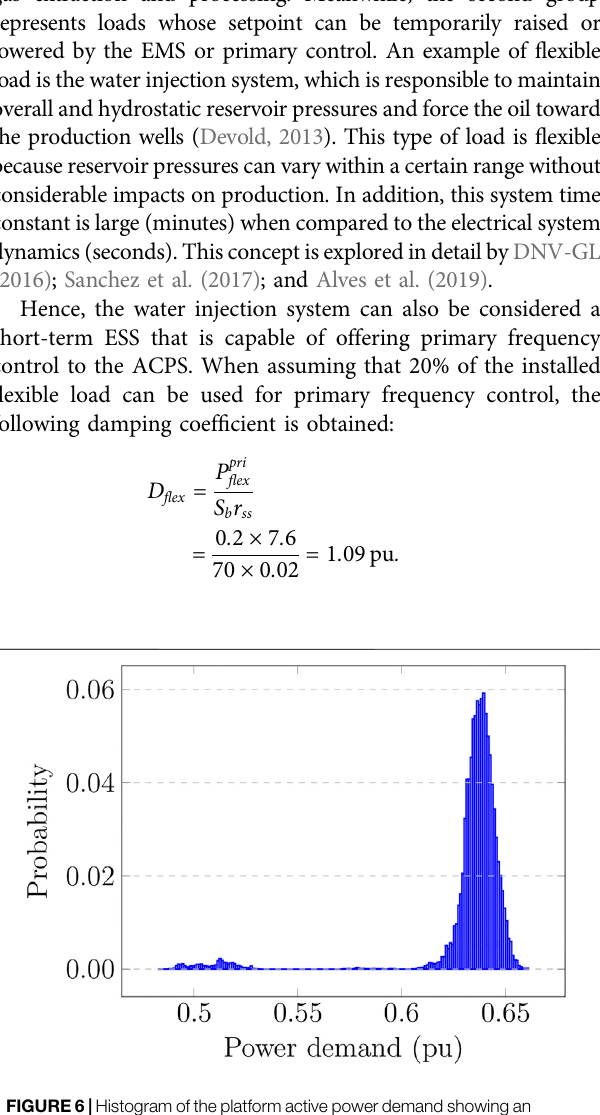
FIGURE6| Histogram oftheplatformactivepowerdemandshowingan averageload of0.6377 puand amaximum variation of0.0428 puwith 99.9% of probability when outliers below 0.6 pu are